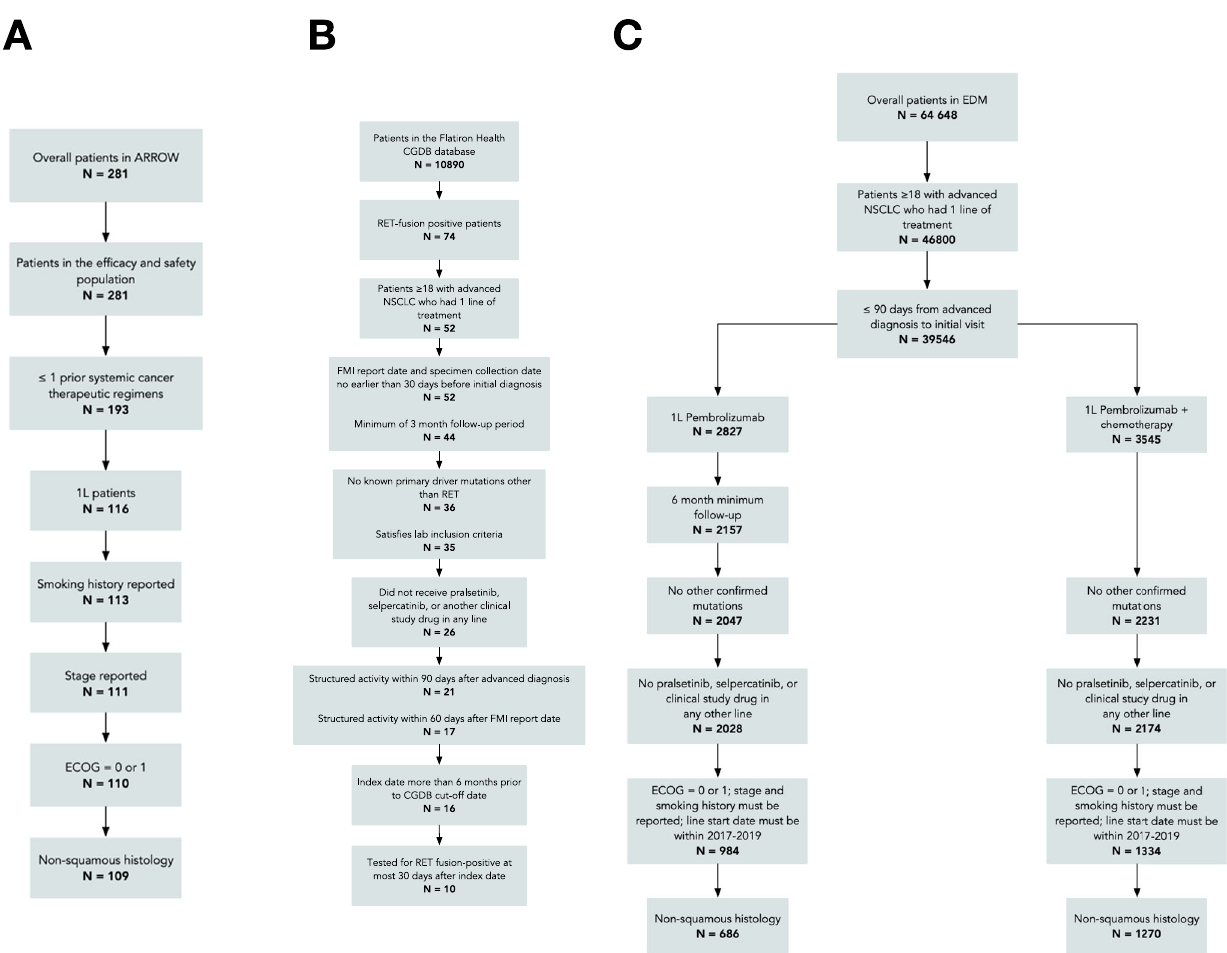
Fig. 4 Flowcharts describing the patient selection process for the cohorts drawn from the ARROW trial, Flatiron Health CGDB, and Flatiron Health EDM datasets. A The fl owchart corresponds to the ARROW trial, B to the Flatiron Health CGDB, and C to the Flatiron Health EDM